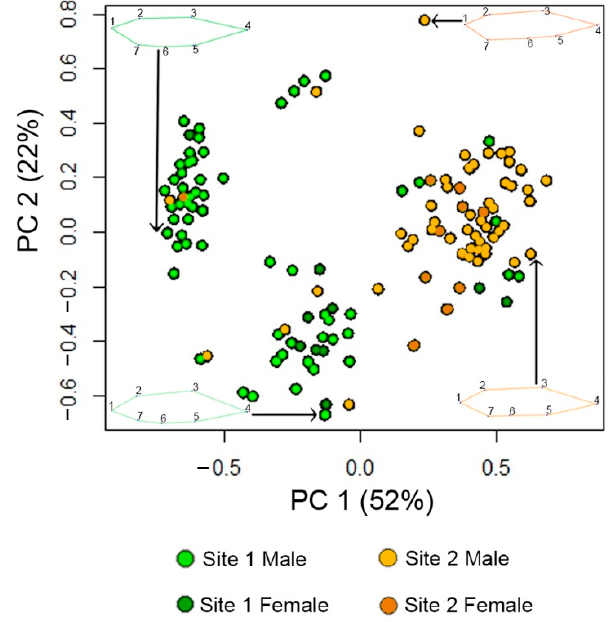
Figure 2. Procrustes PCA plot of variance in partial warps between levels of Population and Sex. The first two Principal Components account for 74% of the variance in consensus shape between populations. The landmarks of specimens at the negative and positive ends of the first and second axes are shown not scaled to size. Site 1 fish are labeled in green, and Site 2 fish are labeled in orange. Lighter shades denote male fish and darker shades denote female fish.